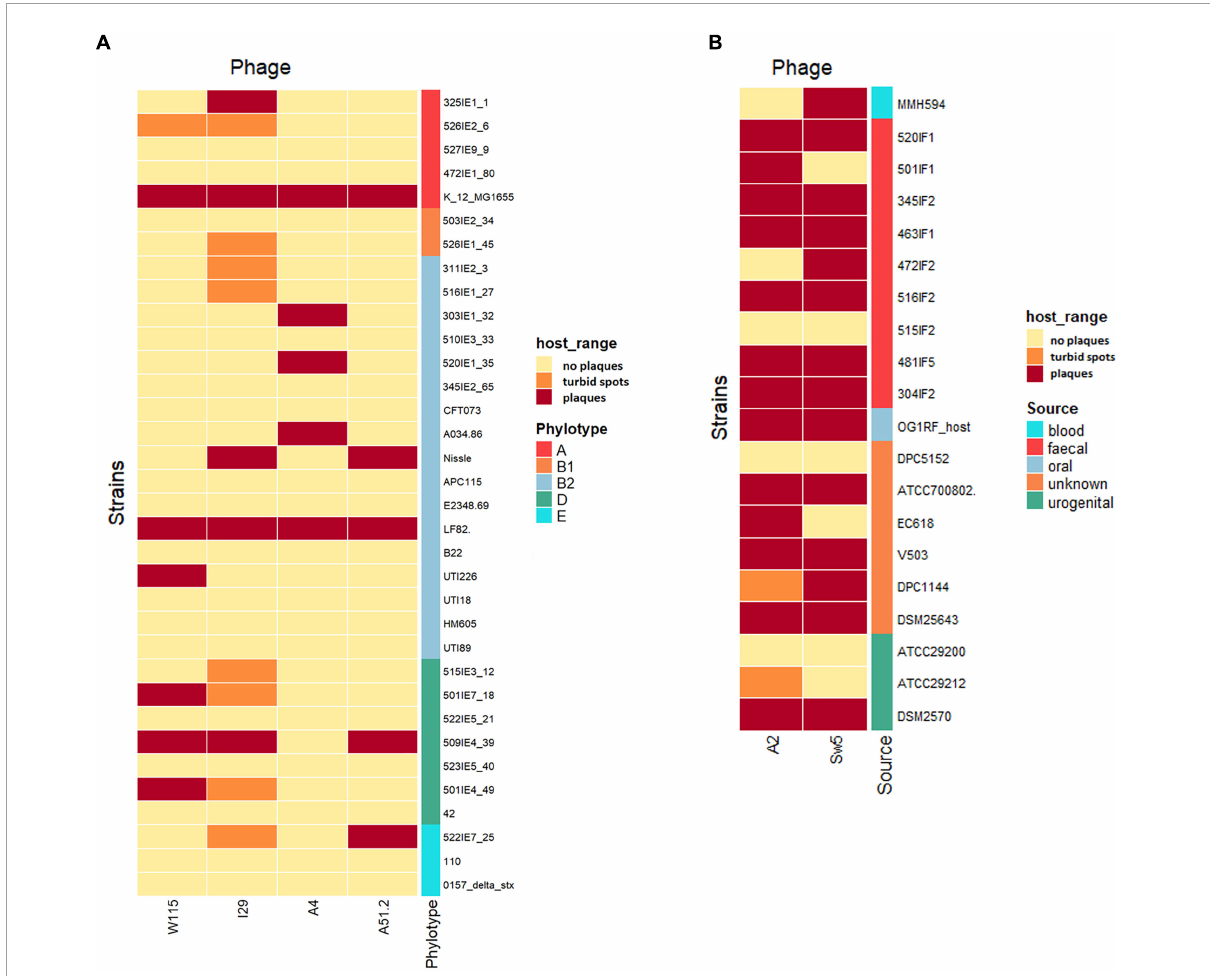
FIGURE2 Host range of (A) Escherichia phage and (B) Enterococcus ( x -axis) phage on different strains of E. coli or E. faecalis ( y -axis) presented as heatmaps, respectively.